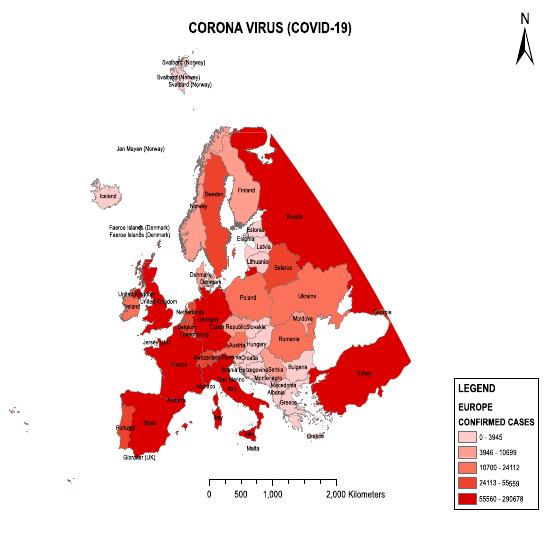
Fig. 7. Spatial distribution of confirmed cases in Europe.